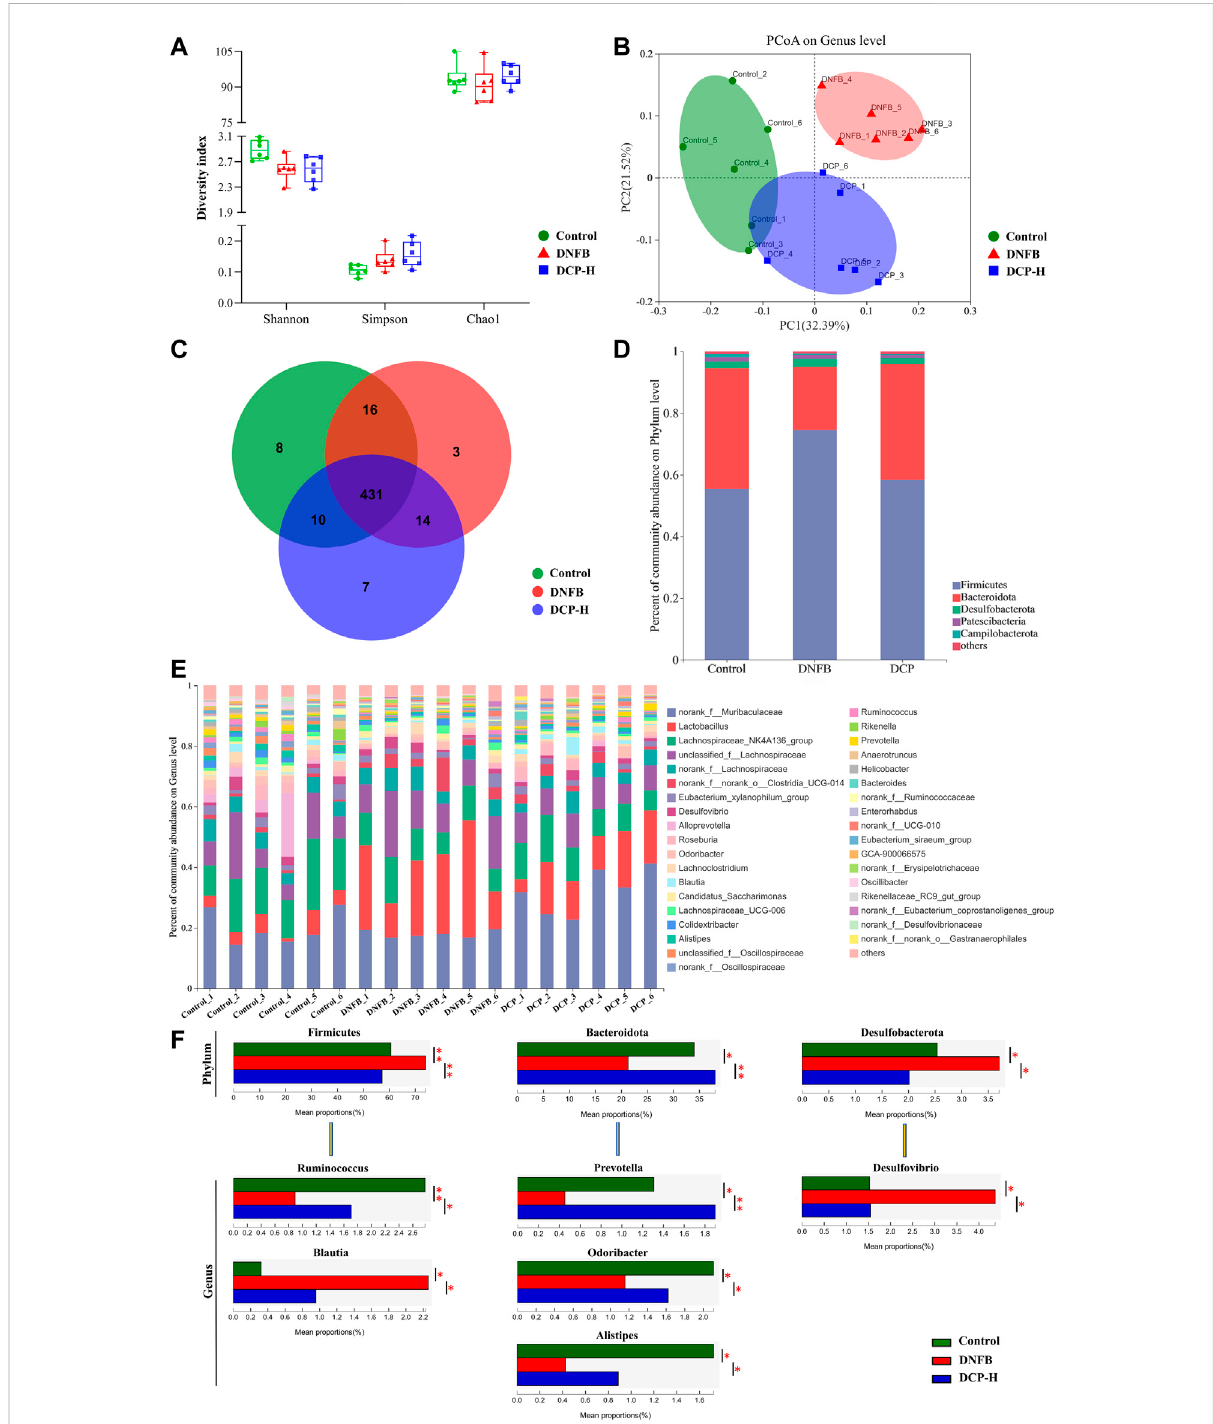
FIGURE 5 Overview of the gut microbiome in different groups. (A) Simpson, Shannon ’ s and Chao1 indices in α -diversity; (B) The principal coordinate analysis (PCoA) of gut microbial on genus level; (C) Venn diagram displayed overlapping and shared OTU data among groups; (D) A barplot showing the distribution of differences in gut microbial phylum levels; (E) The gut microbiome composition at the genus level; (F) Relative abundance of the most affected gut microbiota ( p < 0.05). Data are presented as mean ± SD ( n = 6). Different * represent statistically signi fi cant